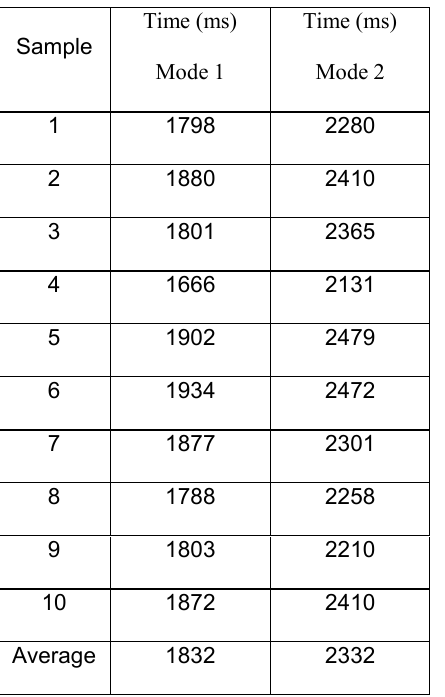
Table 4. The time consuming in two